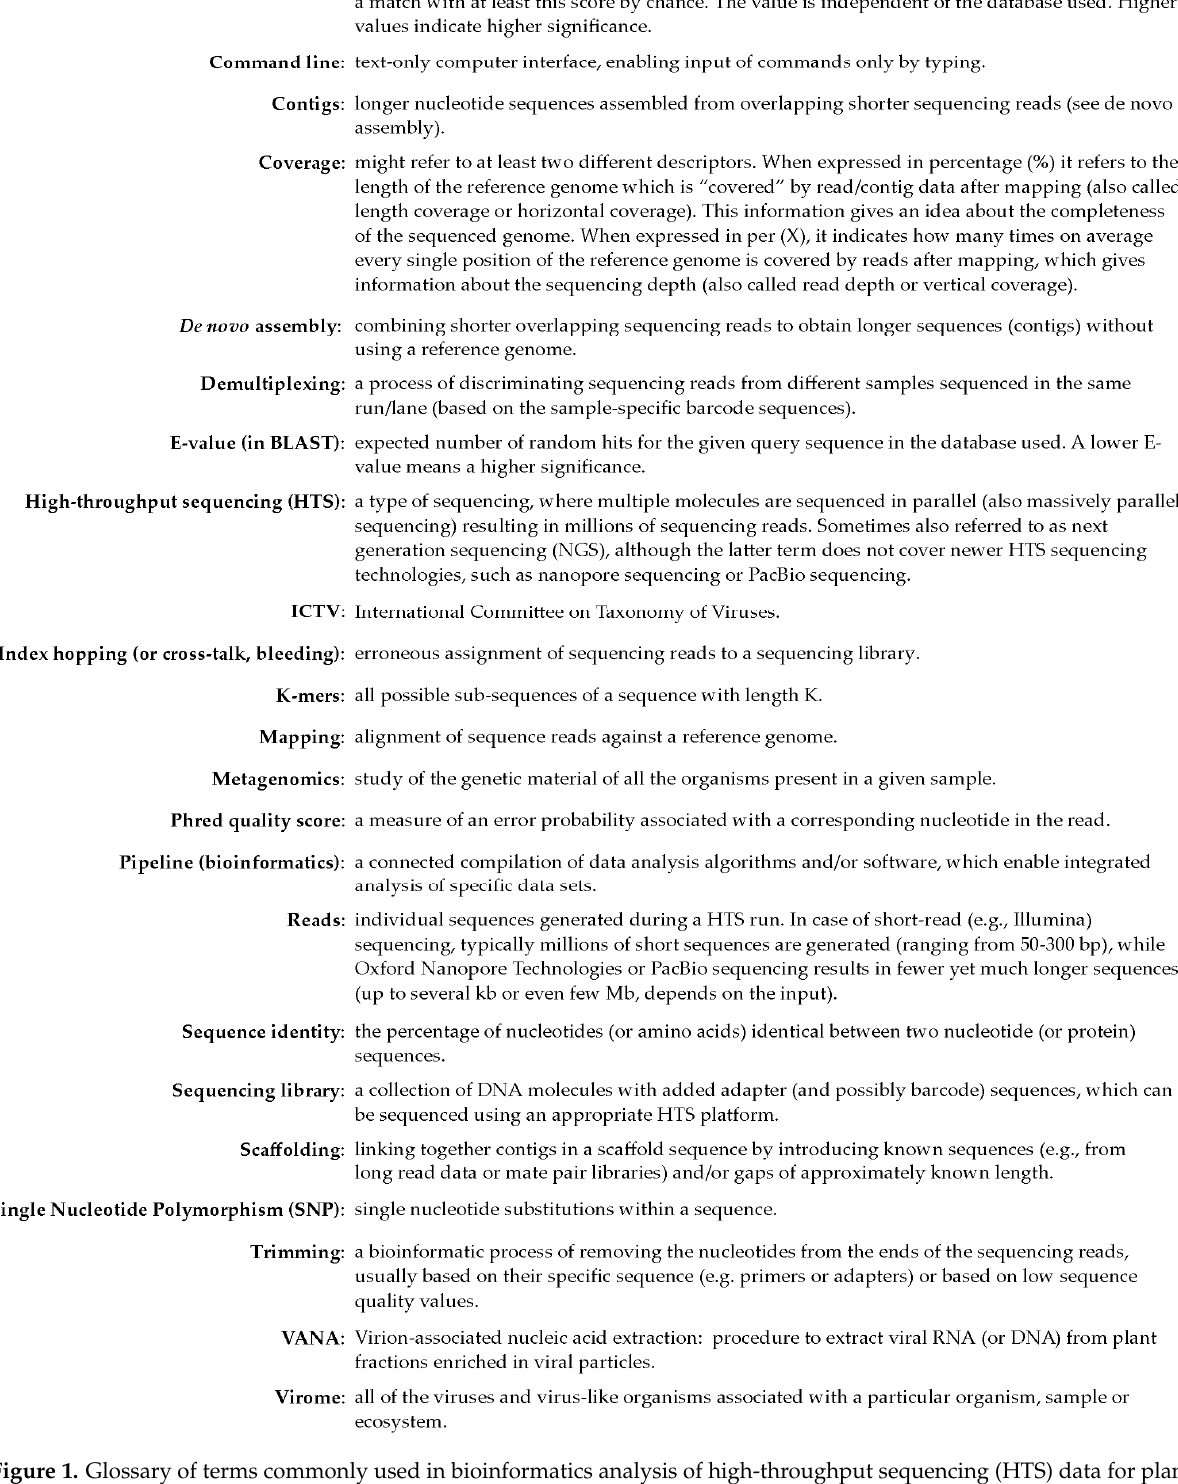
Figure 1. Glossary of terms commonly used in bioinformatics analysis of high-throughput sequencing (HTS) data for plant virus detection.